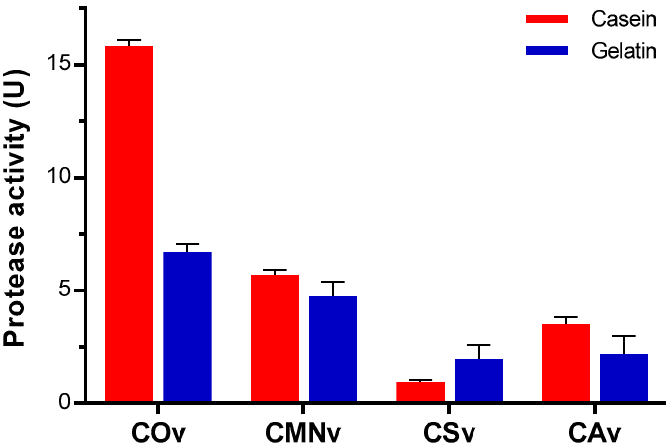
Figure 4. Proteolytic activity for Crotalus venoms using di ff erent substrates. 10 µ g of venom from C. ornatus (COv), C. m. nigrescens (CMNv), C. scutulatus (CSv), and C. atrox (CAv) were incubated with 1% ( w / v ) substrate solution (casein or gelatin) for 1 h at 37 ◦ C. Enzymatic activity is expressed in protease activity units (mmol equivalent of L-leucine formed per minute per mg of protein). Data are presented as the mean of at least three independent experiments with its respective standard error.